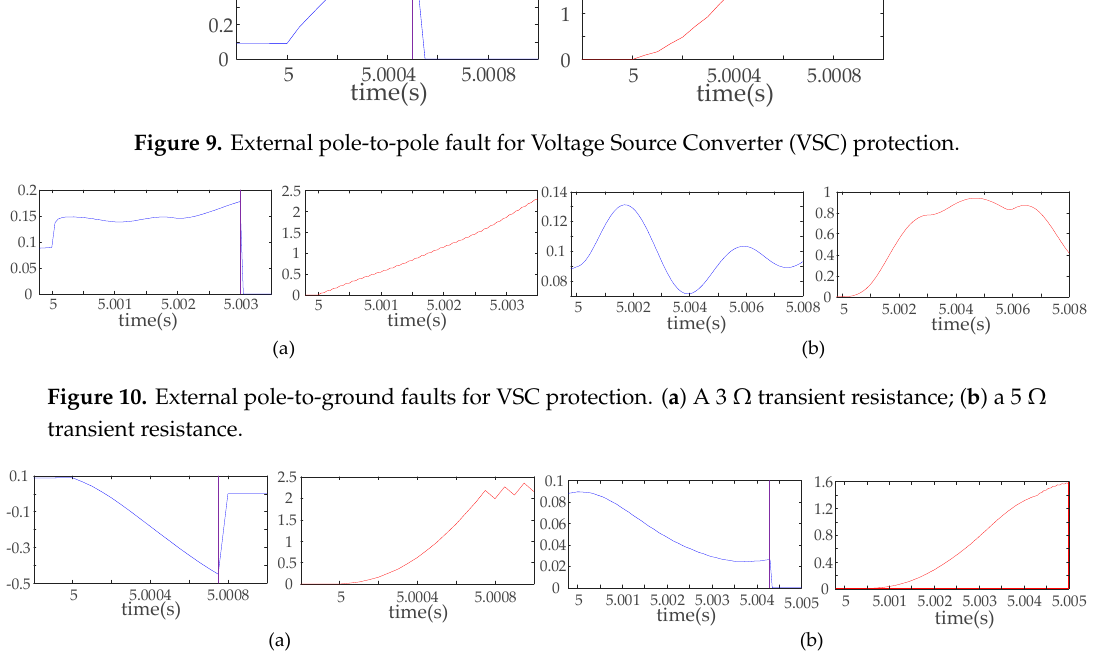
Figure 11. Internal faults for VSC protection. ( a ) Pole-to-pole fault; ( b ) pole-to-ground fault with 5 Ω transient resistance.